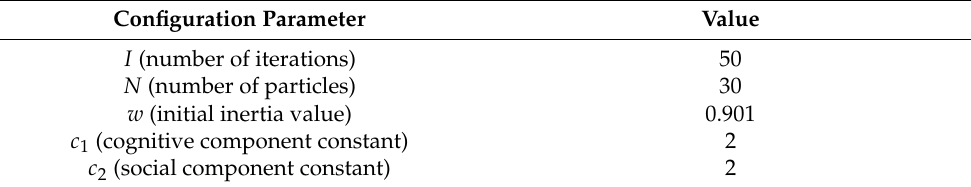
Table 7. BPSO Configuration